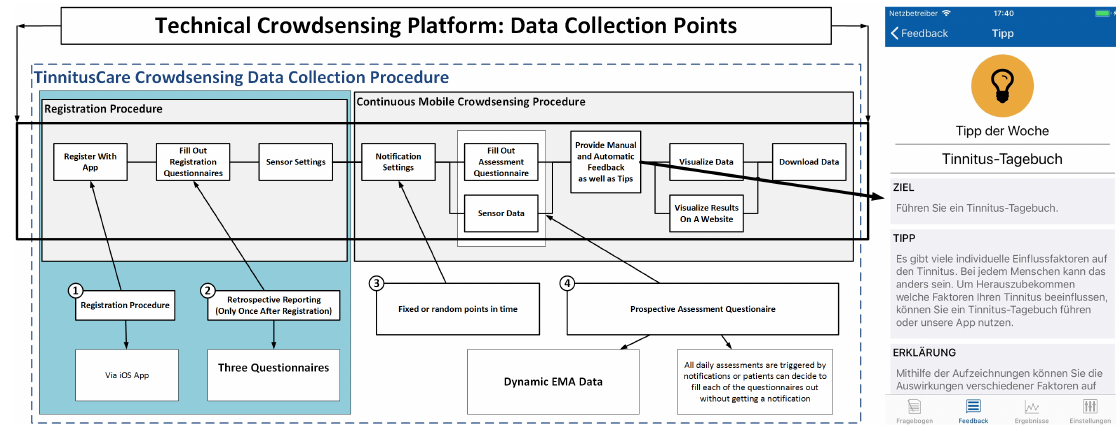
Figure 1. Mobile Crowdsensing Collection Procedure with a Psychoeducation